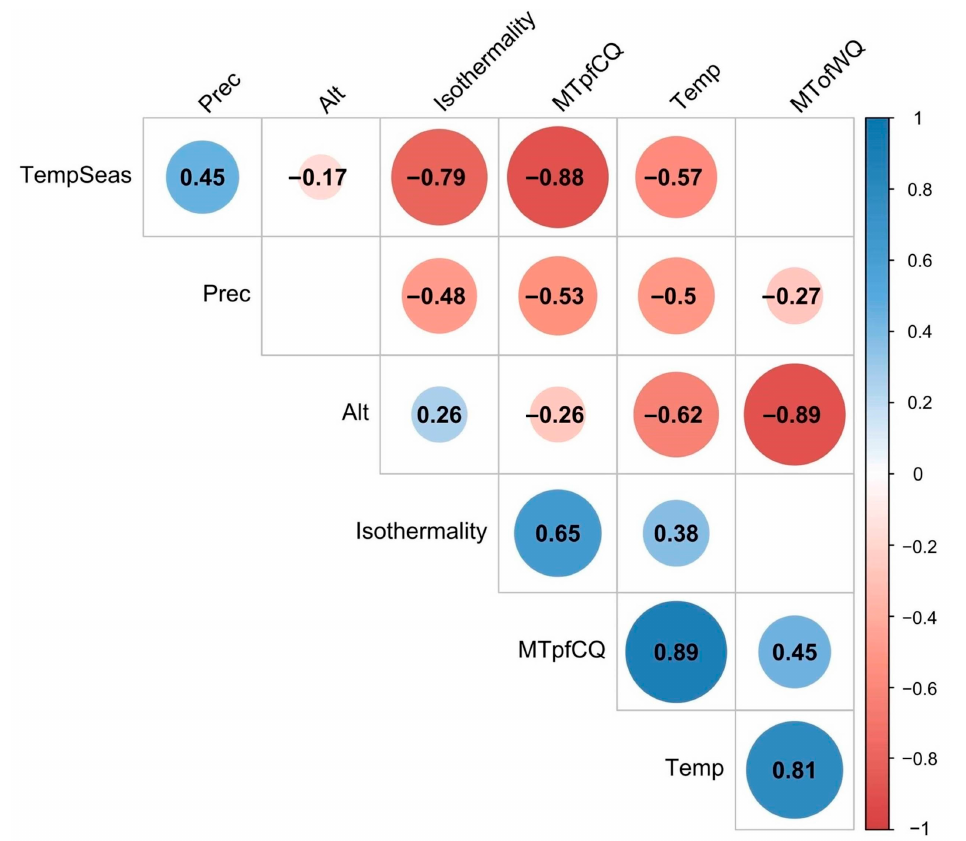
Figure 2. Pairwise Pearson’s correlation coefficients ( r ) between six bioclimatic variables (Temp, Isothermality, TempSeas, MTofWQ, MTofCQ, and Prec; see Table 1) and altitude (ALT). The graph shows only significant correlation values ( p < 0.01). For better visualization, significance is also displayed with the color and size of the circle around the correlation